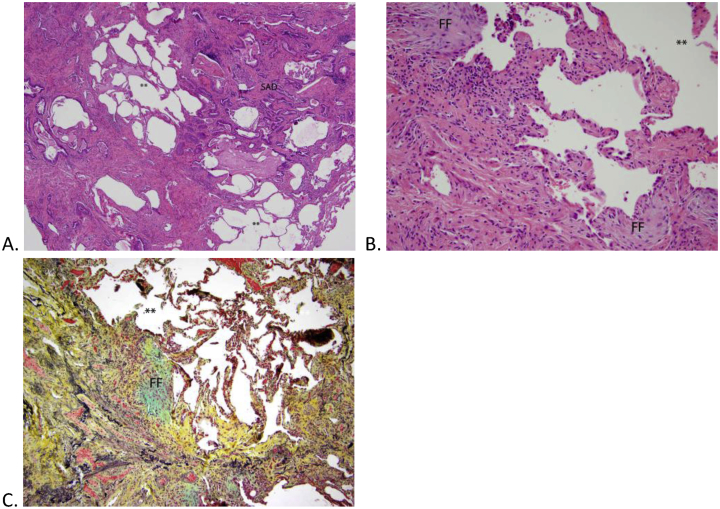
A: Low magnification of the lower lobe shows temporal heterogeneity with dense pink areas representing fibrosis, intervening uninvolved areas (**) and small airways disease (SAD) (top right). B: High magnification demonstrates fibrosis (left lower) and relatively uninvolved areas (**) with fibroblastic foci (FF) separating the two. C: A high magnification on the Movat stain highlights the fibroblastic foci (FF) alongside fibrosis (yellow) and uninvolved lung (**). (For interpretation of the references to colour in this figure legend, the reader is referred to the Web version of this article.)